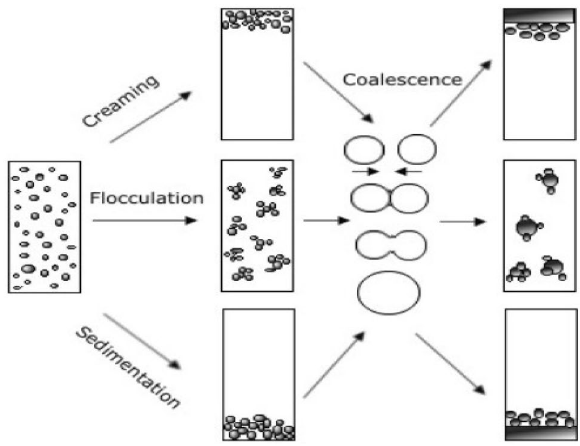
Fig. 10 Processes of emulsions treatment (Auflem